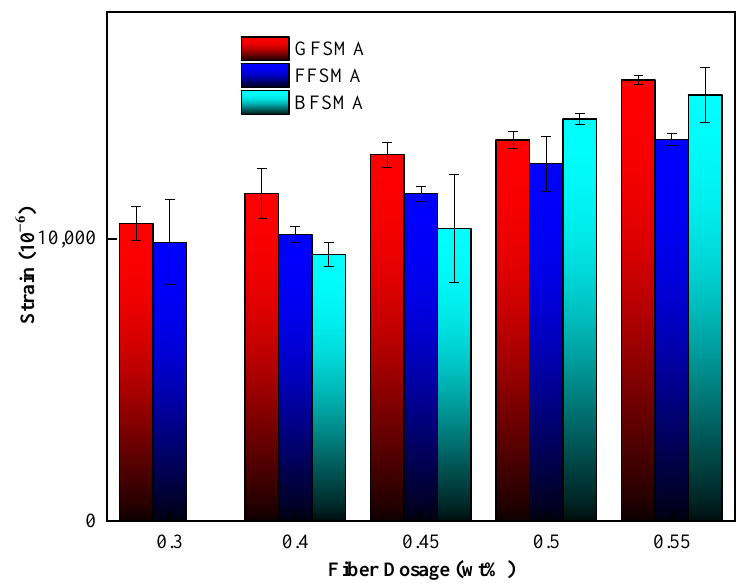
Figure 7. Ultimate strain of mixtures.